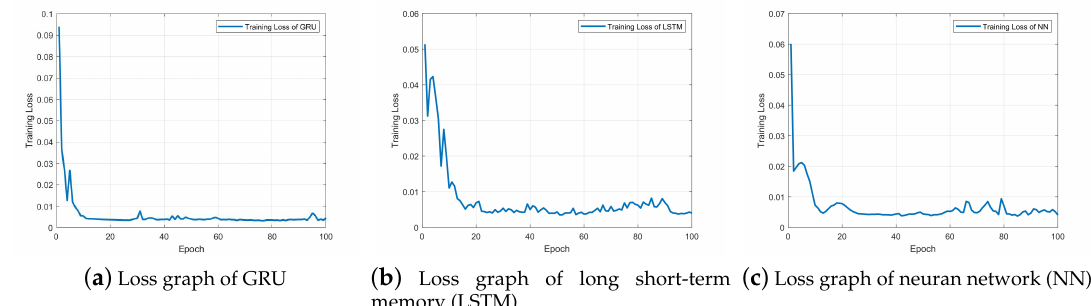
Figure 8. Comparison of training